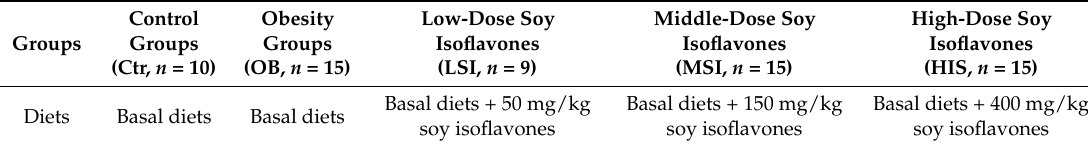
Table 2. Composition of the experimental diets from week eight to week 12.